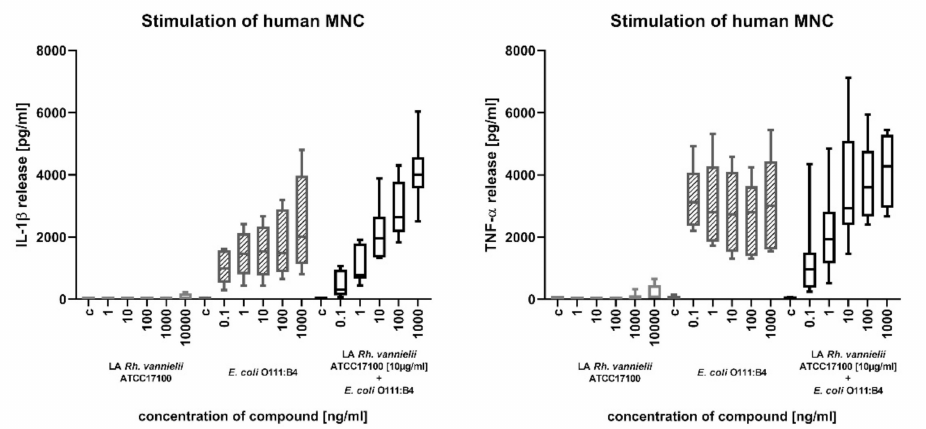
Figure 9. Biological activity of Rv lipid A. Human mononuclear cells were either pre-incubated or not with 10 µ g/mL Rv lipid A (LA R. vannielii ATCC 17100) for 1 h and then stimulated with increasing concentrations of E. coli O111:B4 LPS or with increasing concentrations of Rv lipid A alone. The release of IL-1 β (left panel) or TNF- α (right panel) is shown. Error bars represent the standard deviation of the mean (n = 5 independent